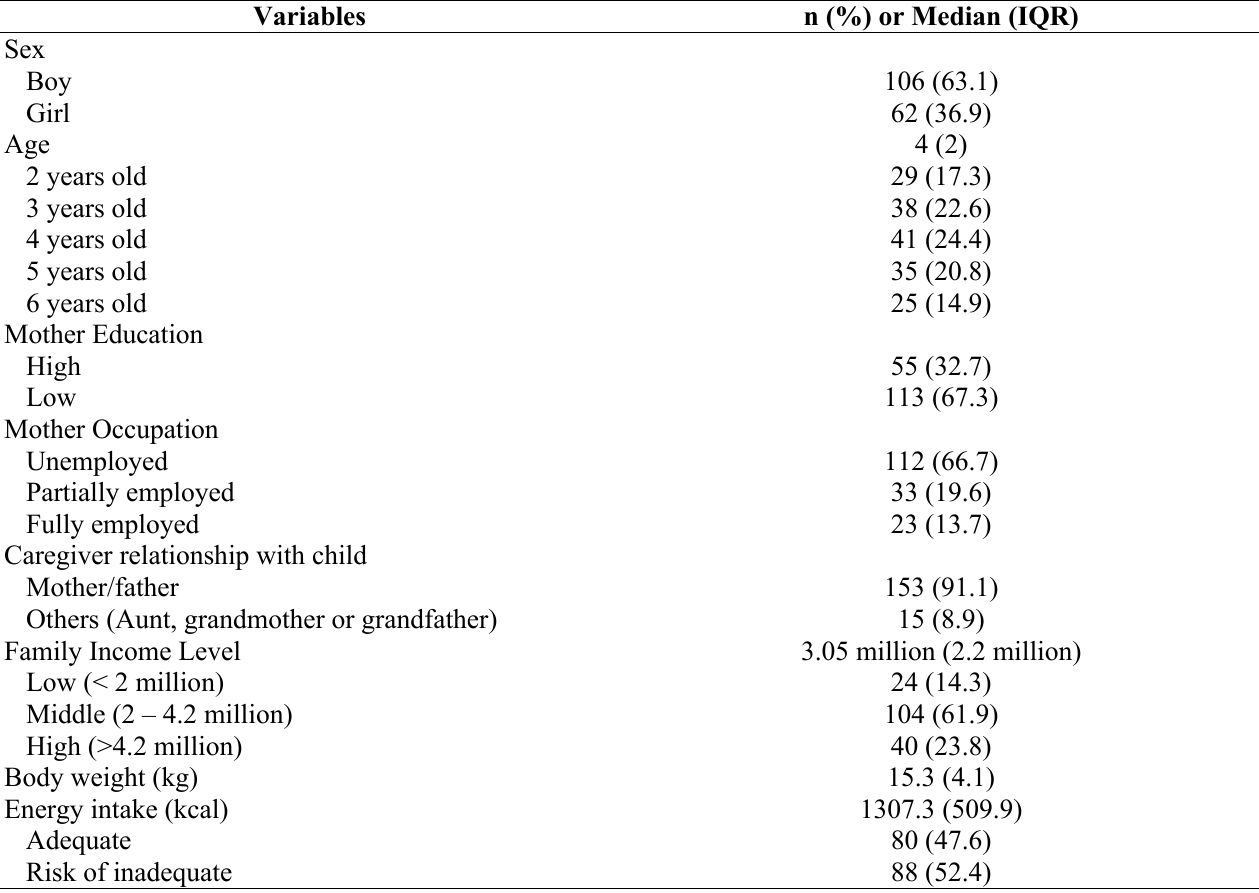
Table 1. Characteristic of children aged 2–6 years old in Pejagalan, North Jakarta (n=168) Variables